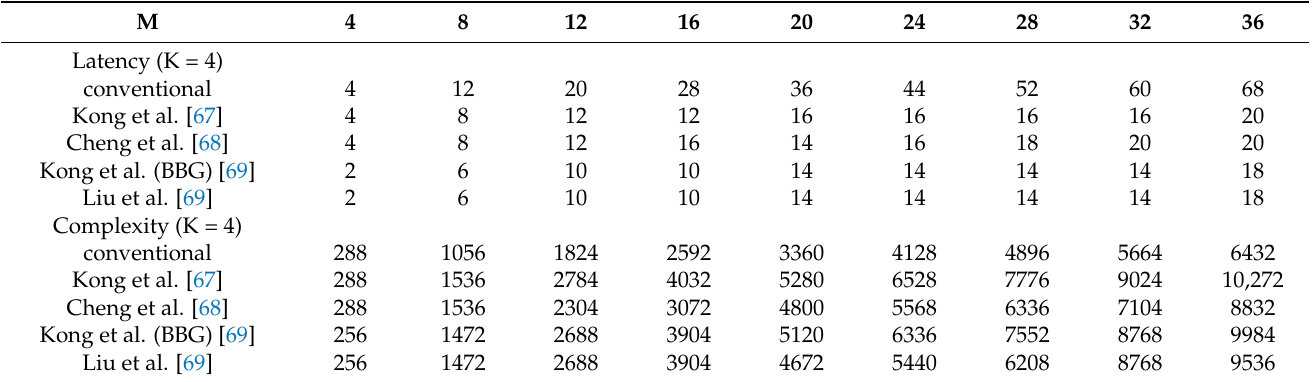
Table 4. Latency and complexity of the